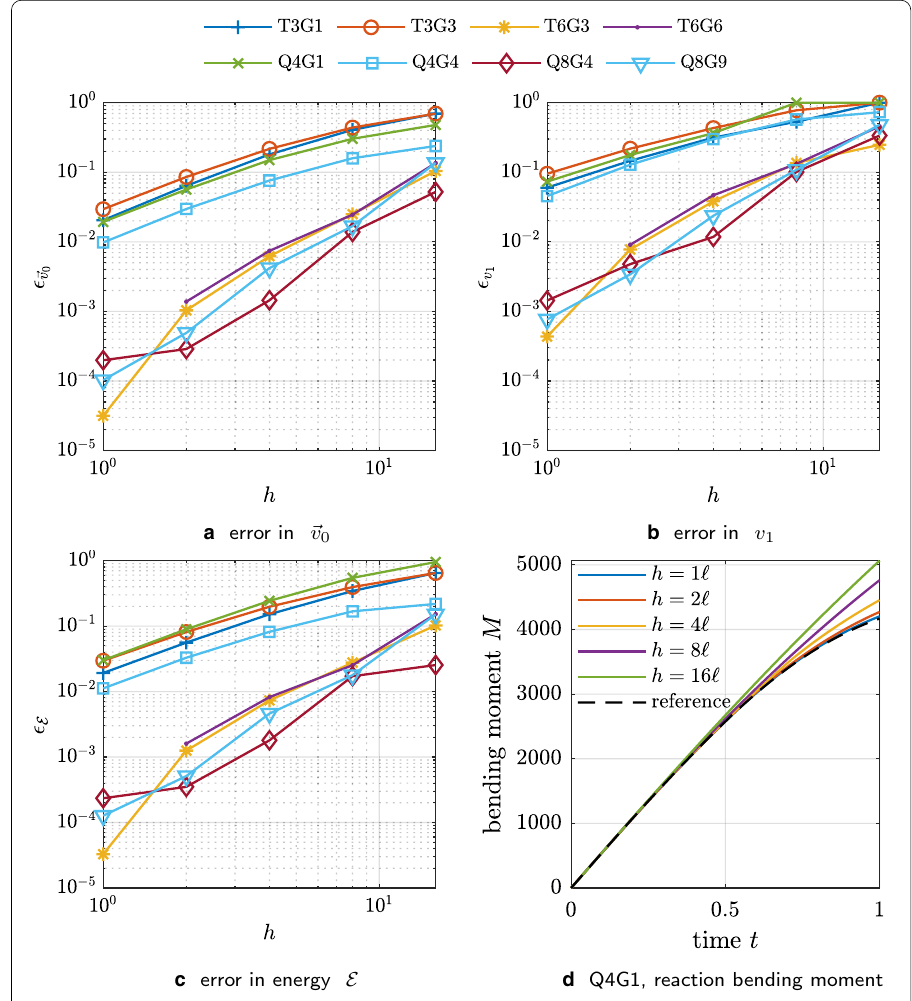
Fig. 7 Convergence of a L 2 displacement error in (cid:2) v 0 ( (cid:2) X ), t = 1, b L 2 micromorphic error in v 1 ( (cid:2) X ), t = 1, and c error in energy evolutions E ( t ), t ∈ [0 , 1]. d Reaction bending moment M ( t ) for Q4G1 and various element sizes h in comparison with the reference solution. Data points for T6G6, h = 1 (cid:20) , are missing, because this solution is considered as the reference solution and the corresponding error thus vanishes